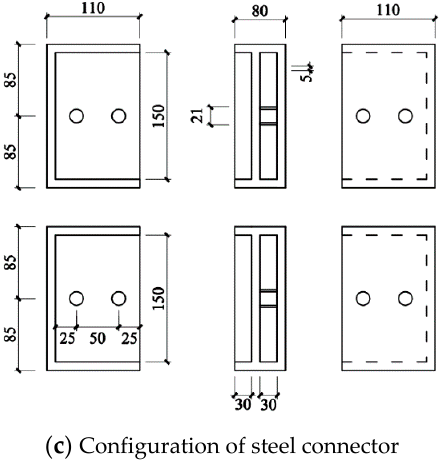
Figure 8. Details dimensions of the prototype structure and steel connector (mm).